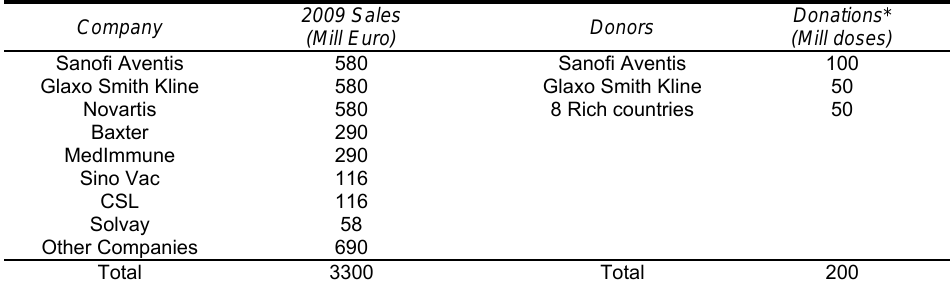
Table 1: Influenza H1N1: Vaccine Sales by Company and Donations